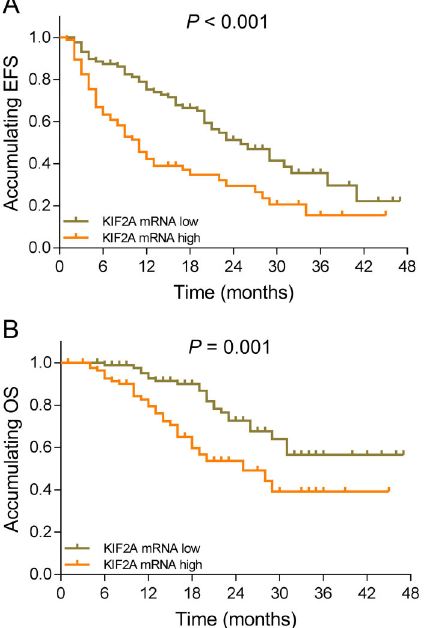
Figure 3. A , Event-free survival (EFS) in KIF2A high expression patients and KIF2A low expression patients. B , Overall survival (OS) in KIF2A high expression patients and KIF2A low expression patients. OS is reported by Kaplan-Meier curves. P o 0.05 was considered signi fi cant (log-rank test). KIF2A: kinesin family member